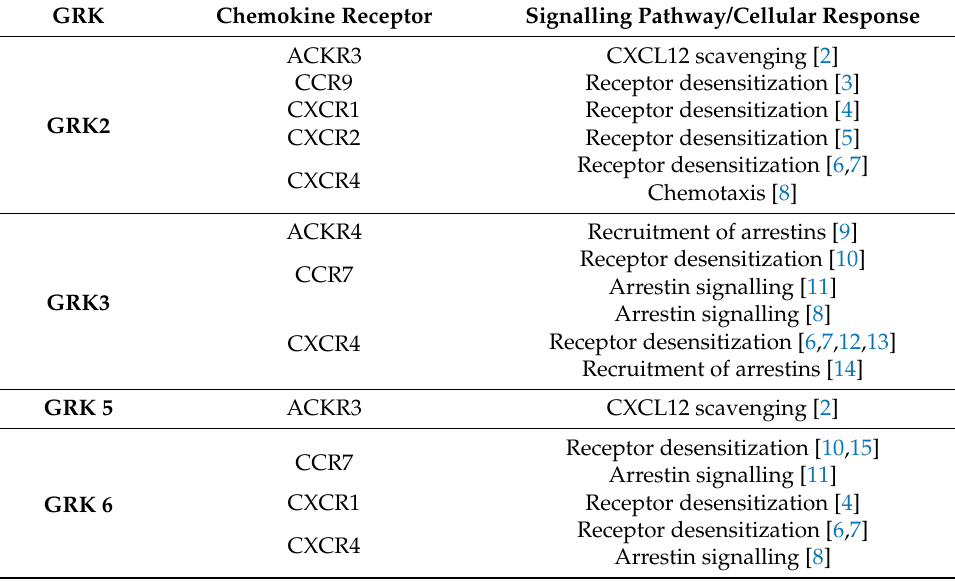
Table 1. G protein-coupled receptor kinases (GRKs) and their chemokine receptor partners.